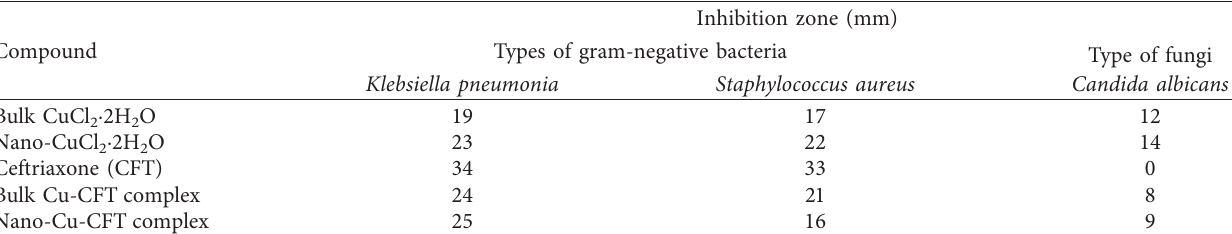
Table 11: Inhibition zones for antibacterial activity (gram-negative bacteria) and antifungal activity ( Candida albicans ).